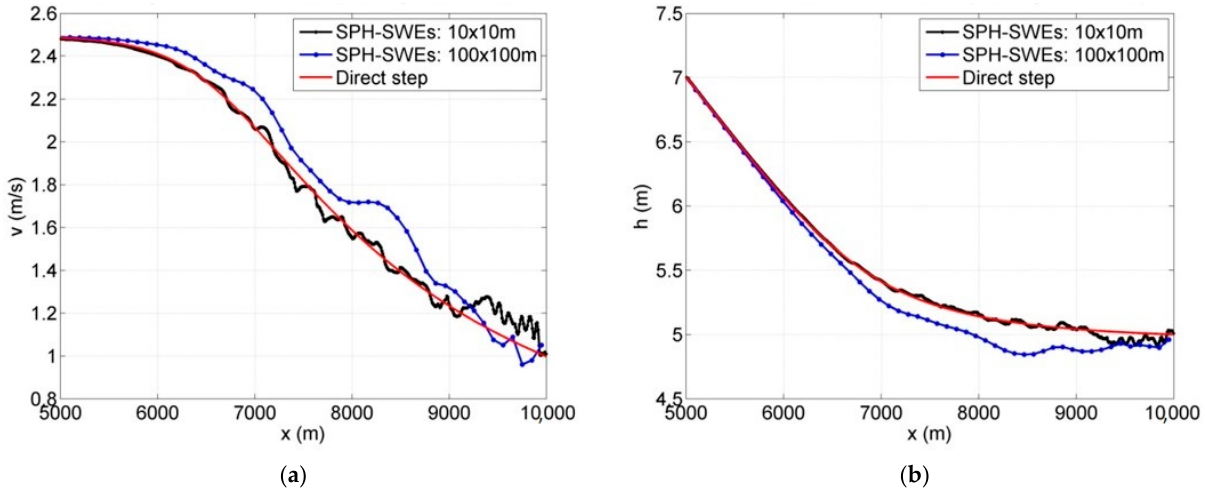
Water 2021 , 13 , x FOR PEER REVIEW Figure 5. Results of 2D simulation for M1 curve longitudinal profile: ( a ) velocity and ( b ) water level. Figure 5. Results of 2D simulation for M1 curve longitudinal profile: ( a ) velocity and ( b ) water level. Figure 5. Results of 2D simulation for M1 curve longitudinal profile: ( a ) velocity and ( b ) water level.